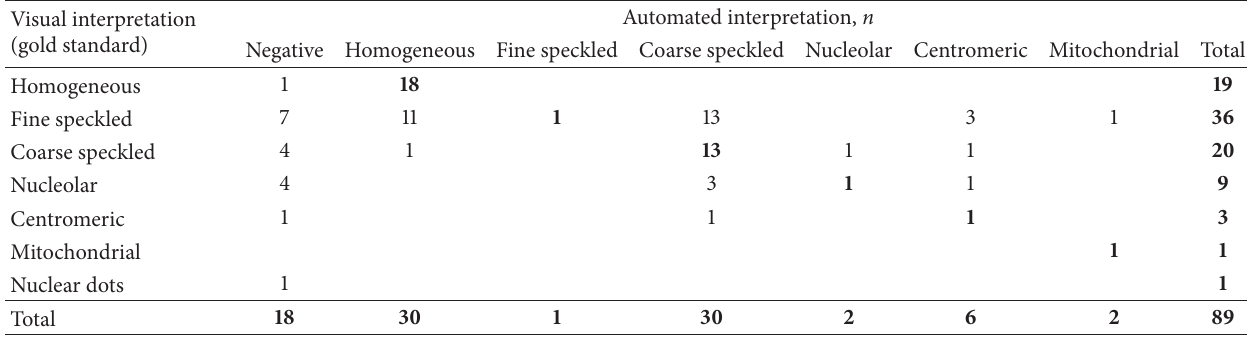
Table 3: Visual versus automated detected patterns of antinuclear antibodies by indirect immunofluorescence. Crosstabulation of antinuclear antibodies (ANA) titres by indirect immunofluorescence (IIF) for 89 serum samples that revealed a positive result by visual interpretation of the ANA-IIF-assay 2; concordant results are shown in bold.